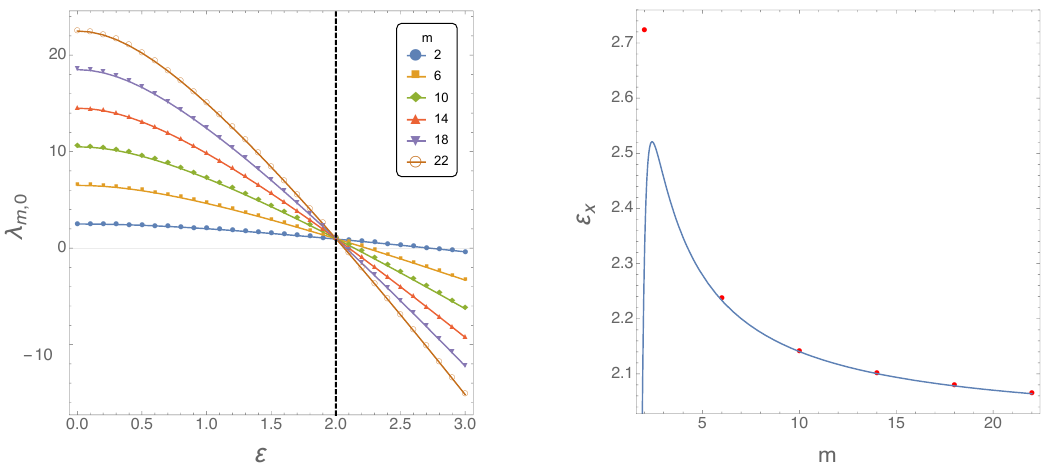
Figure 17 . Left : lowest lying mode eigenvalue of the boundary hamiltonian as a function of the boundary rotation parameter " . At " = 0 these reduce to ‘ +1 = 2. Right : " above which (cid:21) m; 0 becomes negative, plotted as a function of m . The solid line represents our analytic approximation (6.2) valid at large m